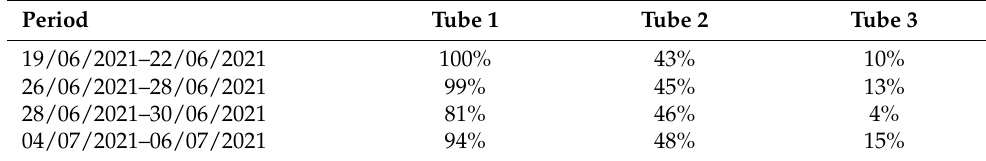
Table 6. Air flow rate percentage difference between Tube 4 and each of the rest of the tubes. Period Tube 1 Tube